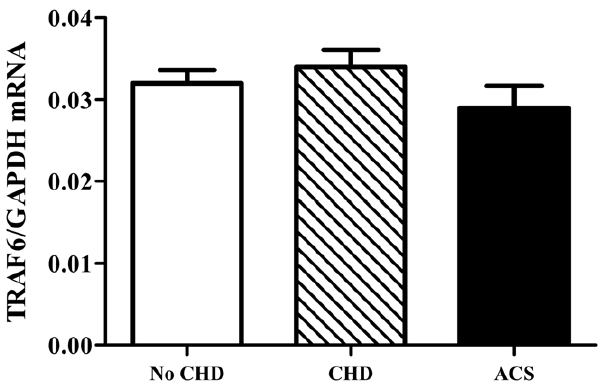
Figure 8. TRAF6 expression in blood does not associate with acute or chronic coronary heart disease. 325 patients undergoing coronary angiography were divided into three groups: no coronary heart disease (No CHD, N=77), stable coronary heart disease (CHD, N=178), and acute coronary syndromes (ACS, N=70). TRAF6 and GAPDH mRNA was analyzed by quantitative real-time PCR in total blood RNA. Results are presented as mean 6 SD computed from the average measurements obtained from each group.